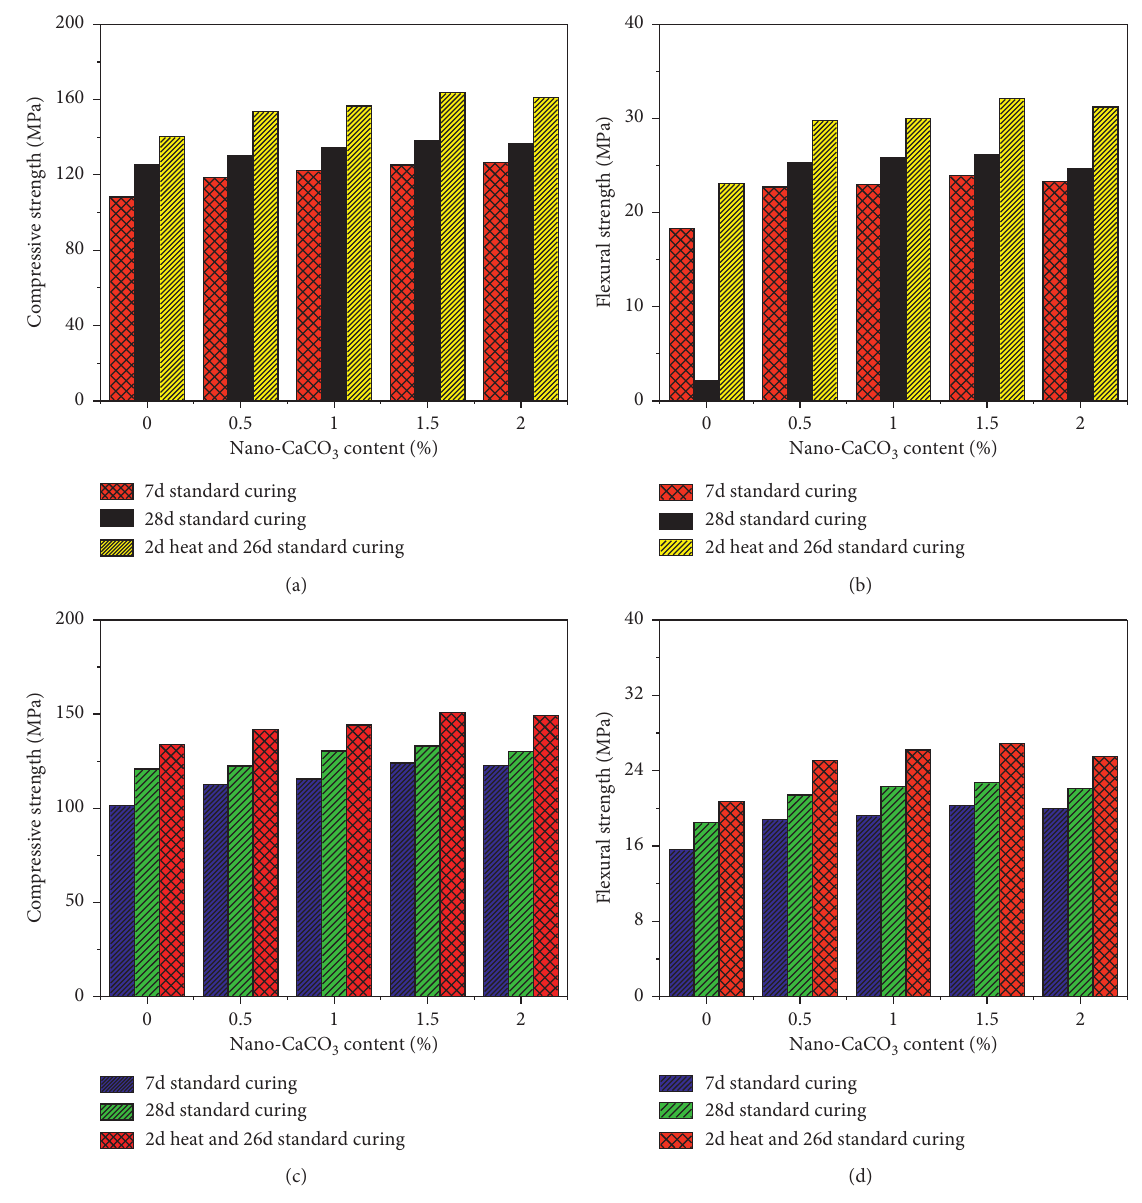
Figure 15: Effect of nano-CaCO 3 content on the mechanical strength of UHPC under different water-binder ratios [38]: (a) w/b (b) w/b � 0.16, (c) w/b � 0.17, and (d) w/b �